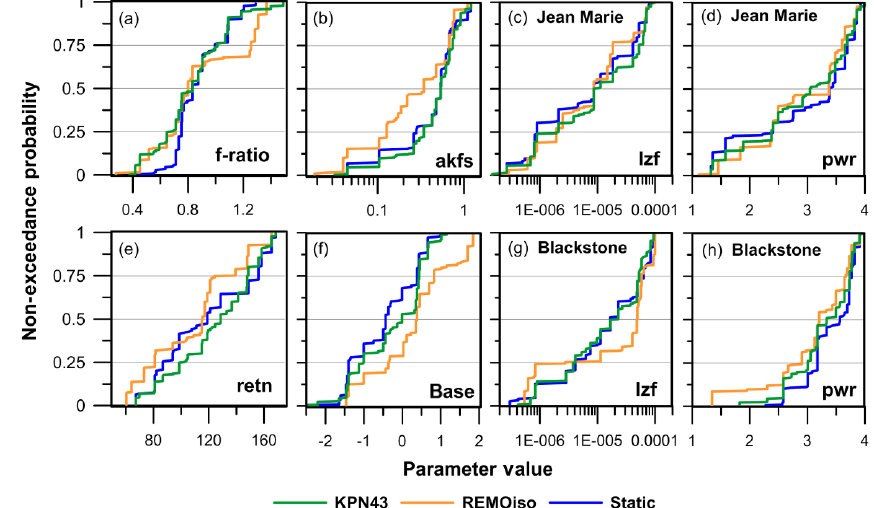
Figure 7. Probability distributions for selected parameters (Table 5), as indicated in the bottom right corner of each panel. Parameters are from behavioural simulations, and (a) , (b) , (e) , and (f) have been weighted to the land cover distribution within Jean-Marie and Blackstone, as outlined in Table 1. (c) and (d) are river class parameters within Jean-Marie, and (g) and (h) contain river class parameters for